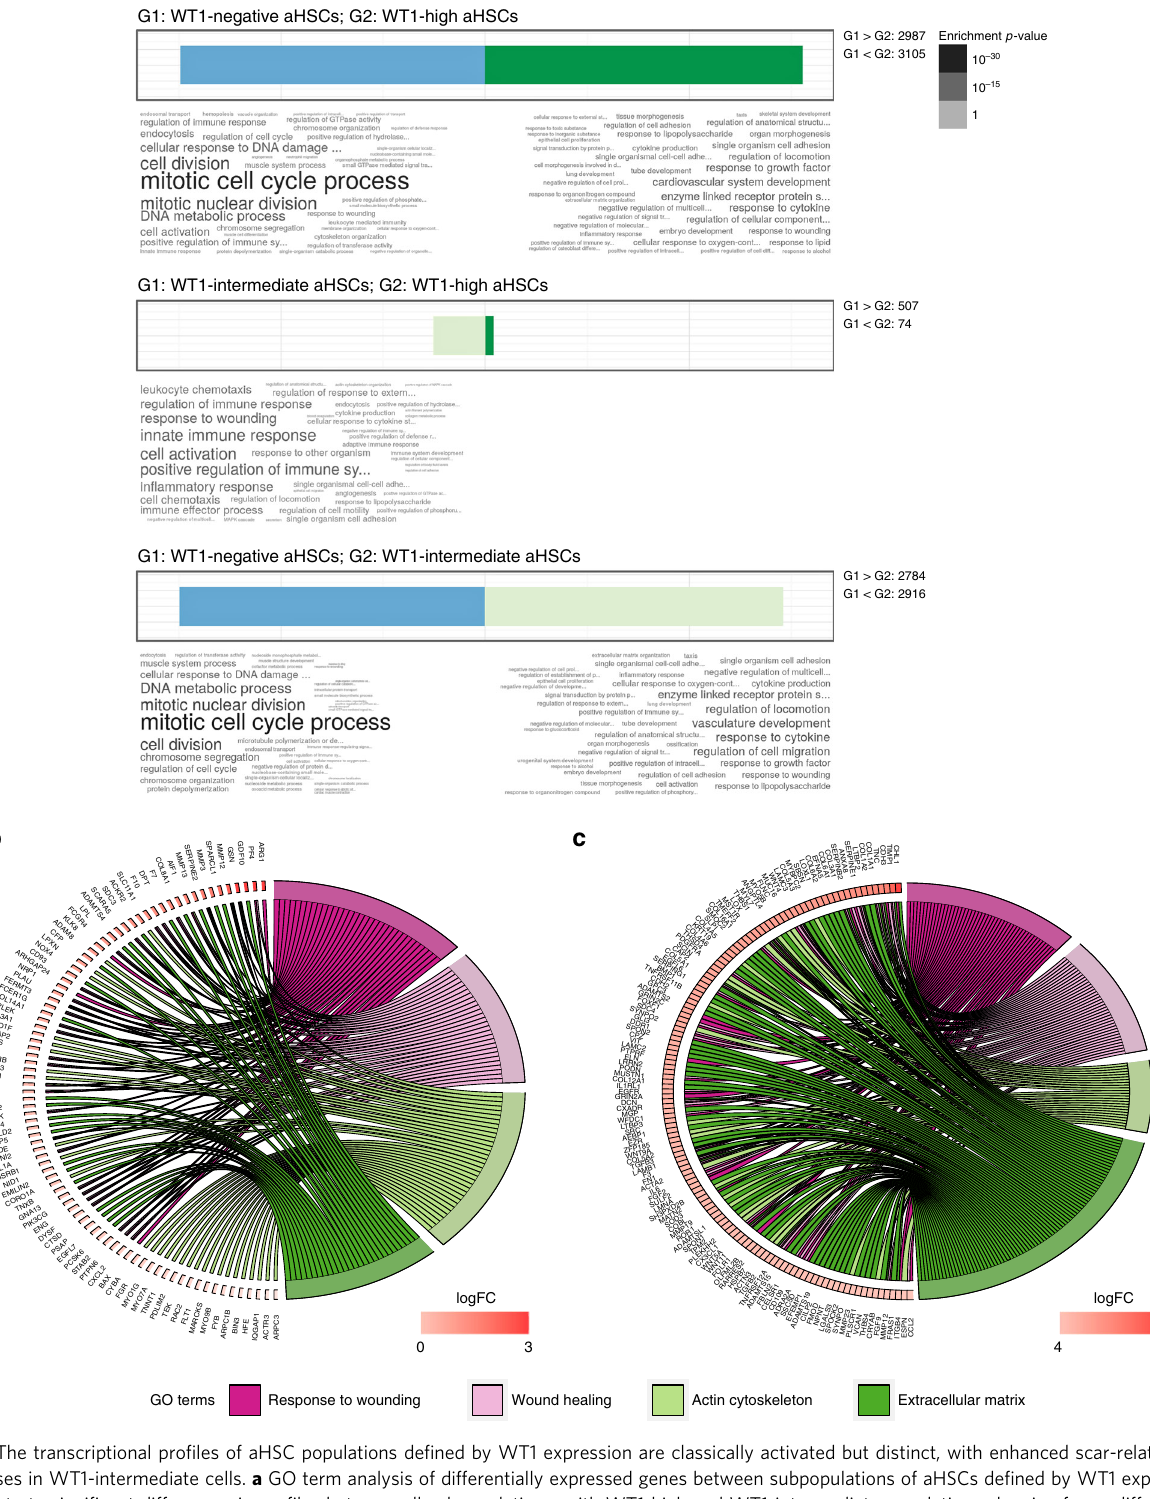
Fig. 6 The transcriptional pro fi les of aHSC populations de fi ned by WT1 expression are classically activated but distinct, with enhanced scar-related processes in WT1-intermediate cells. a GO term analysis of differentially expressed genes between subpopulations of aHSCs de fi ned by WT1 expression demonstrate signi fi cant differences in pro fi les between all subpopulations, with WT1-high and WT1-intermediate populations showing fewer differences. b Speci fi c mapping of differentially expressed genes to GO terms for indicative scarring responses demonstrate the enhancement in WT1-intermediate aHSCs compared with WT1-high aHSCs. c The transcriptome, determined by RNAseq, of aHSCs isolated from PDGFR β Cre;WT1 GFP/ + animals ( n = 6) with liver fi brosis induced by iterative injury with CCl 4 was compared with that of quiescent lineage-label positive HSCs from WT1 CreERT2/ + ;Ai14 animals ( n = 3) induced at E10.5. Gene ontology terms mapped to differentially expressed genes for WT1-high cells demonstrate engagement of cellular processes associated with the HSC activation